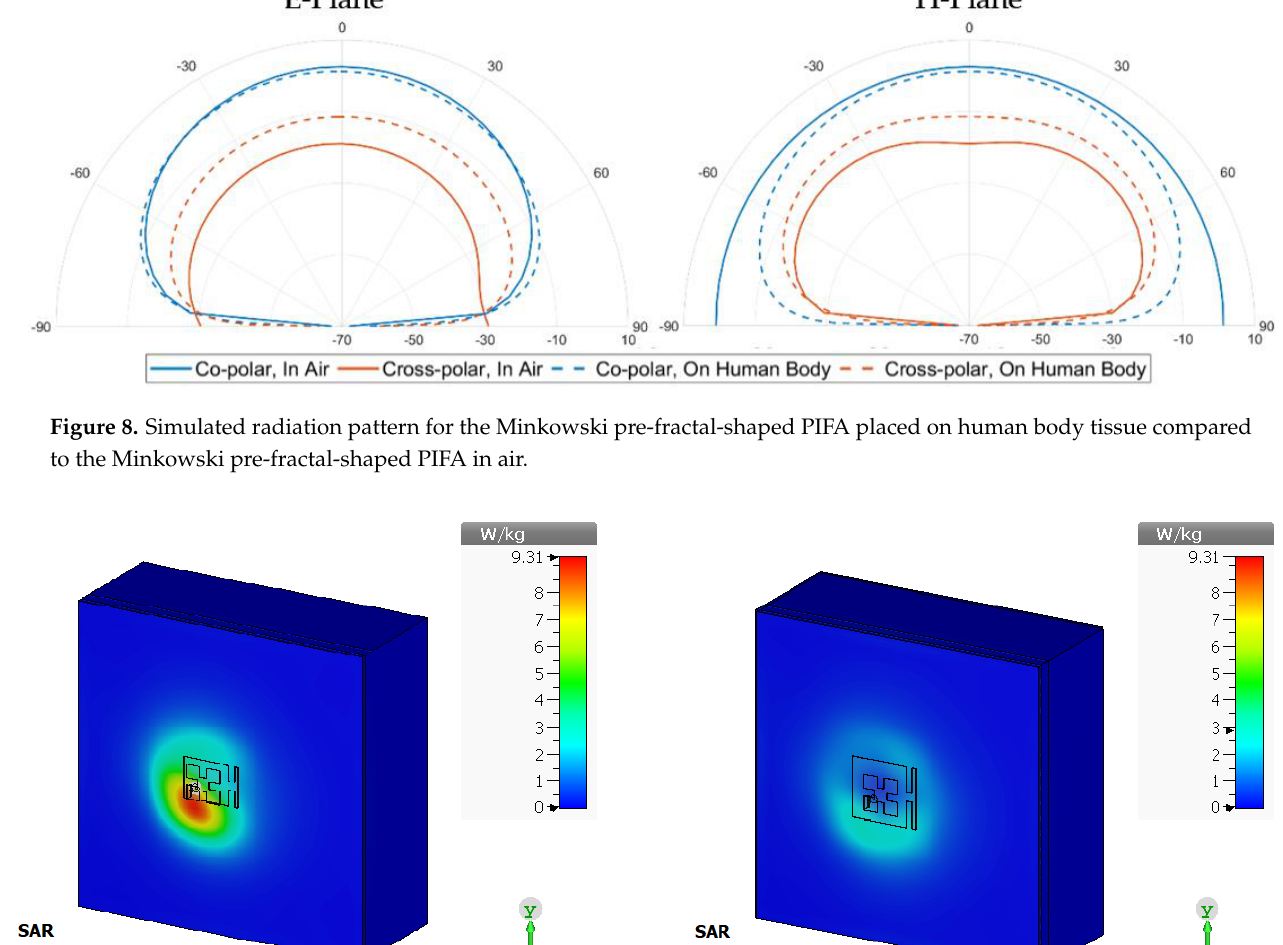
Figure 8. Simulated radiation pattern for the Minkowski pre-fractal-shaped PIFA placed on human body tissue compared to the Minkowski pre-fractal-shaped PIFA in air.